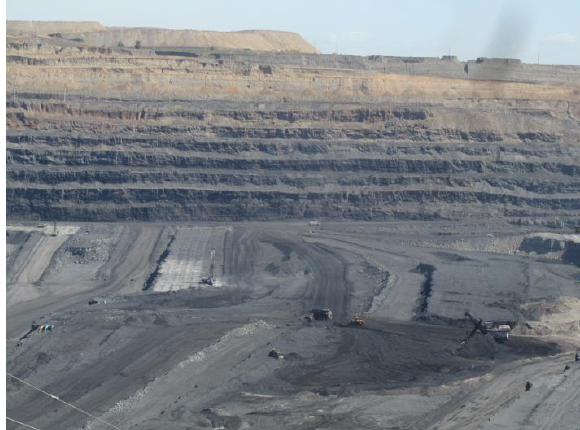
Figure 4. North slope topography of the Anjialing open-pit mine.